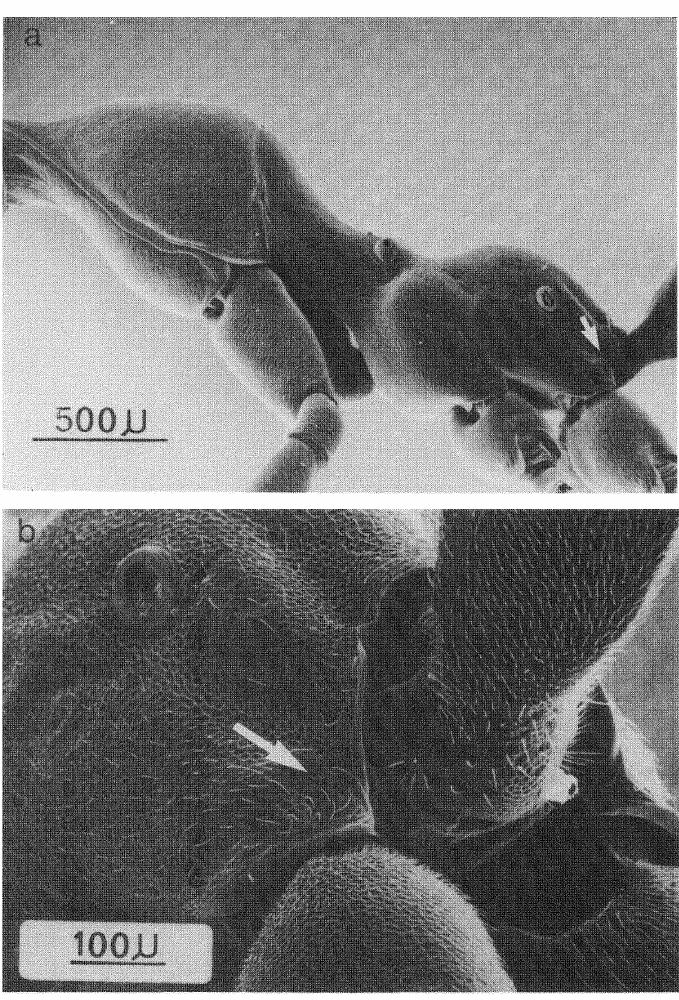
Fig. 4. a. SEM micrograph of the mesosoma of a worker of Oecophylla long# noda. b. Close-up of the posterolateral corners of the alitrunk. Arrows indicate the area where the opening of a metapleural gland should be